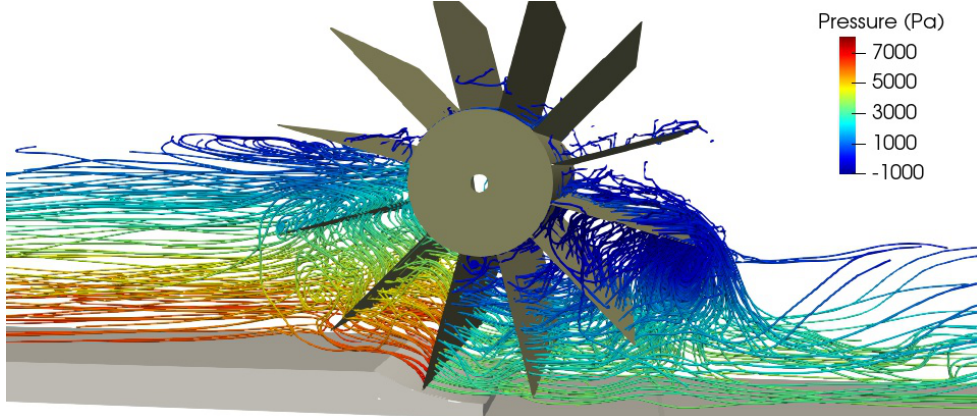
Figure 22. Image of instantaneous streamlines through the HPM colored by pressure, Q = 120 L/s.